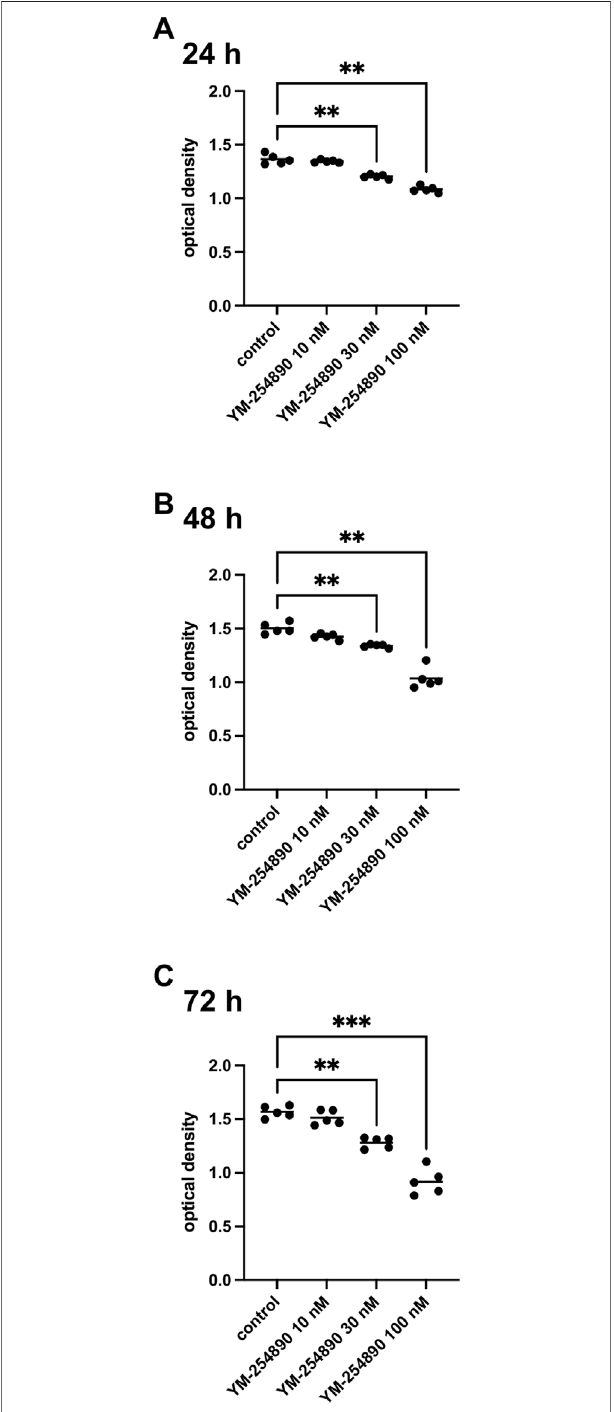
FIGURE 9 | Viability of prostate stromal cells (WPMY-1) after exposure to YM-254890. Shown are values for optical density from CCK-8 assays, re fl ecting the amounts of viable prostate stromal cells after 24 h (A) , 48 h (B) , and 72 h (C) from series using cell cultures from n = 5 independent experiments for each indicatedtime.Thecellswereeitherallocatedtoacontrol(DMSO,10 μ l/ml)orYM- 254890(10,30,and100 nM)groupandincubatedfor24,48,and72 h(* p < 0.05, ** p < 0.01,*** p < 0.001).Shownarethequanti fi cationsofallexperimentsasoptical density(mean)asscatterplotscontainingdataofeachindividualexperiment (A – C)